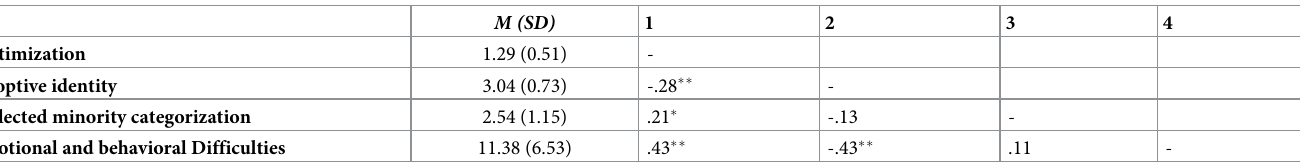
Table 1. Means ( M ), Standard Deviations ( SD ) and Correlations between the study variables ( N =